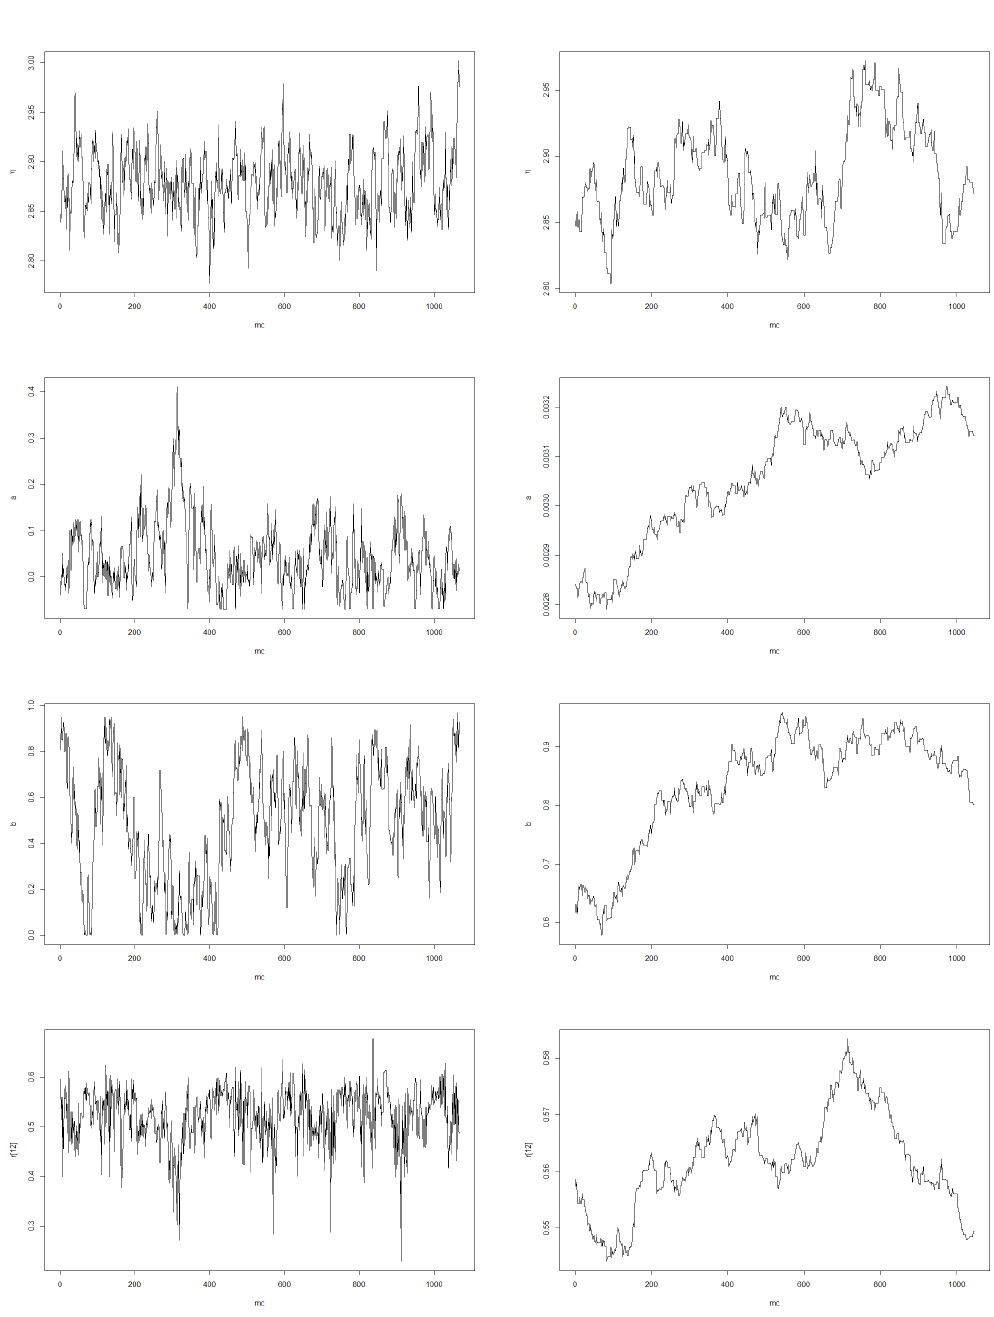
Figure 3: Chains of parameter draws for η , a , b , and r 1,2 ; CHMC (left) and RW-MCMC